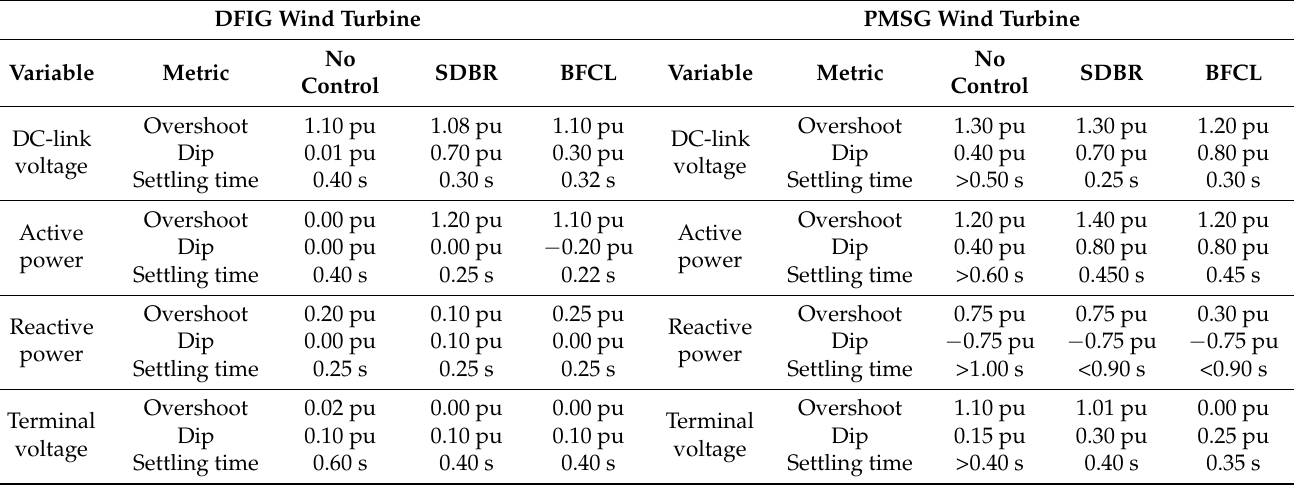
Table 3. Numerical Index Performance of the Wind Turbines.